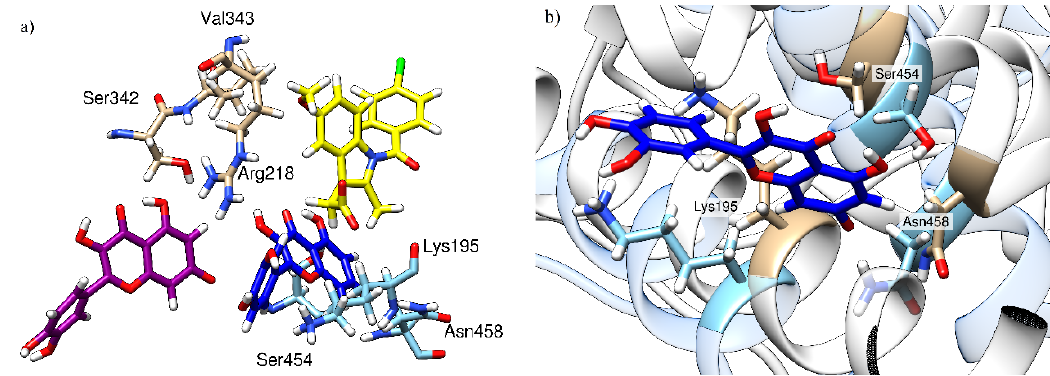
Figure 7. Relative quercetin orientation in the absence (purple) and in the presence (dark blue) of indomethacin (yellow) with three amino acids contributing the most to its binding. ( a ) Comparison of the relative quercetin locations in the absence and in the presence of indomethacin; ( b ) local changes in HSA conformation between a binary HSA-indomethacin complex (HSA depicted in brown, indomethacin is not shown) and a ternary HSA-indomethacin–quercetin complex (HSA is depicted in light blue, quercetin in dark blue, and indomethacin is not